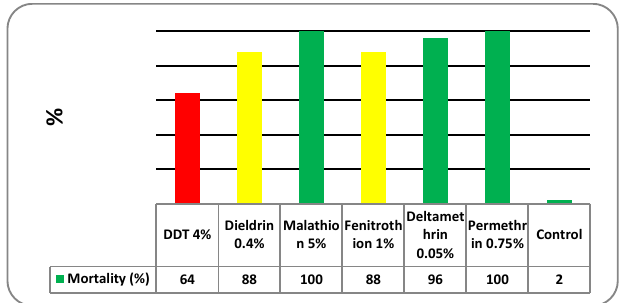
Figure 4: Susceptibility status of An. sacharovi to different insecticides in Poldasht County, West Azarbijan Province, Northwest of Iran, 2001